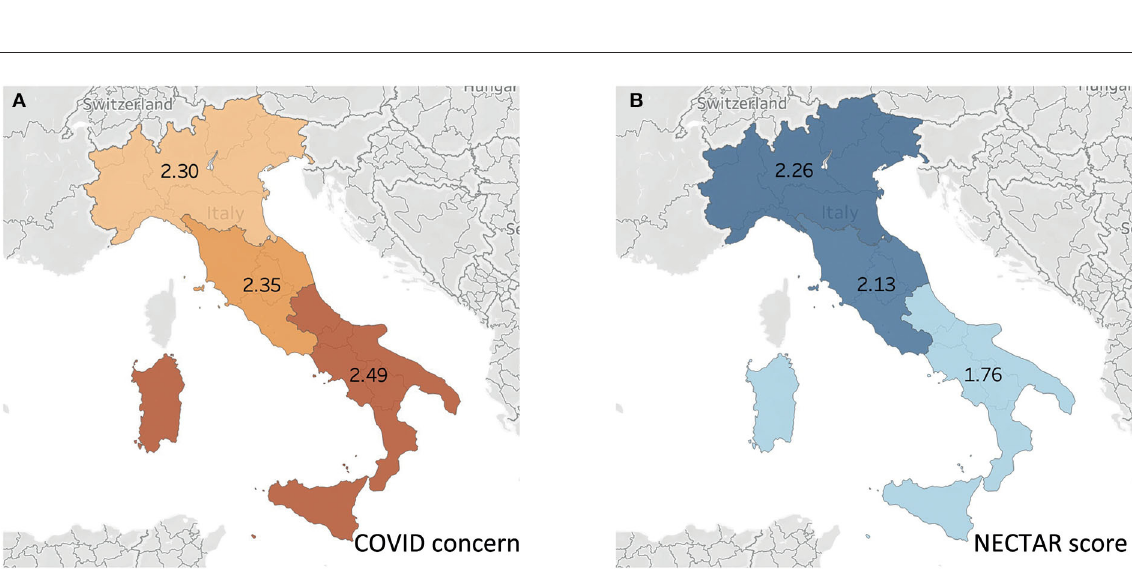
FrontiersinPublicHealth